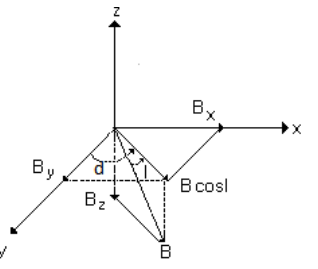
Figure 1. The geometry of the Earth’s Magnetic Field (for the North- ern